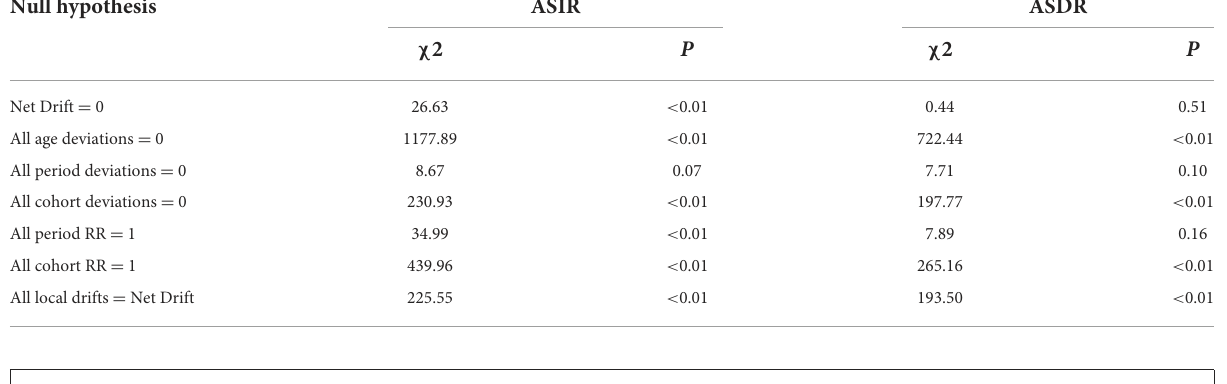
TABLE 2 Wald Chi Square tests for estimable functions in the age-period-cohort model.